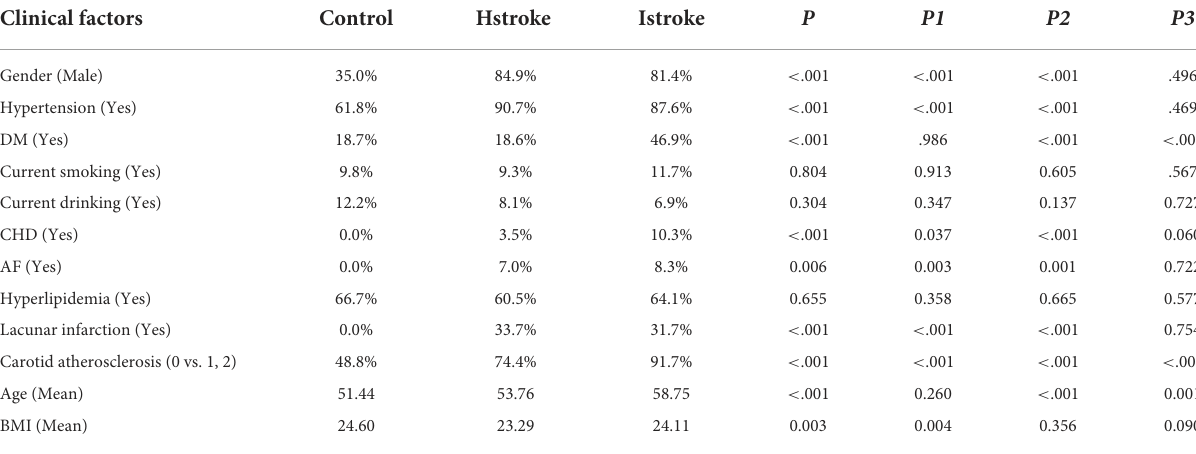
TABLE 4 The distribution of estimated Clinical risk factors for the three classes of control, Ischemic stroke and Hemorrhagic Stroke. Clinical